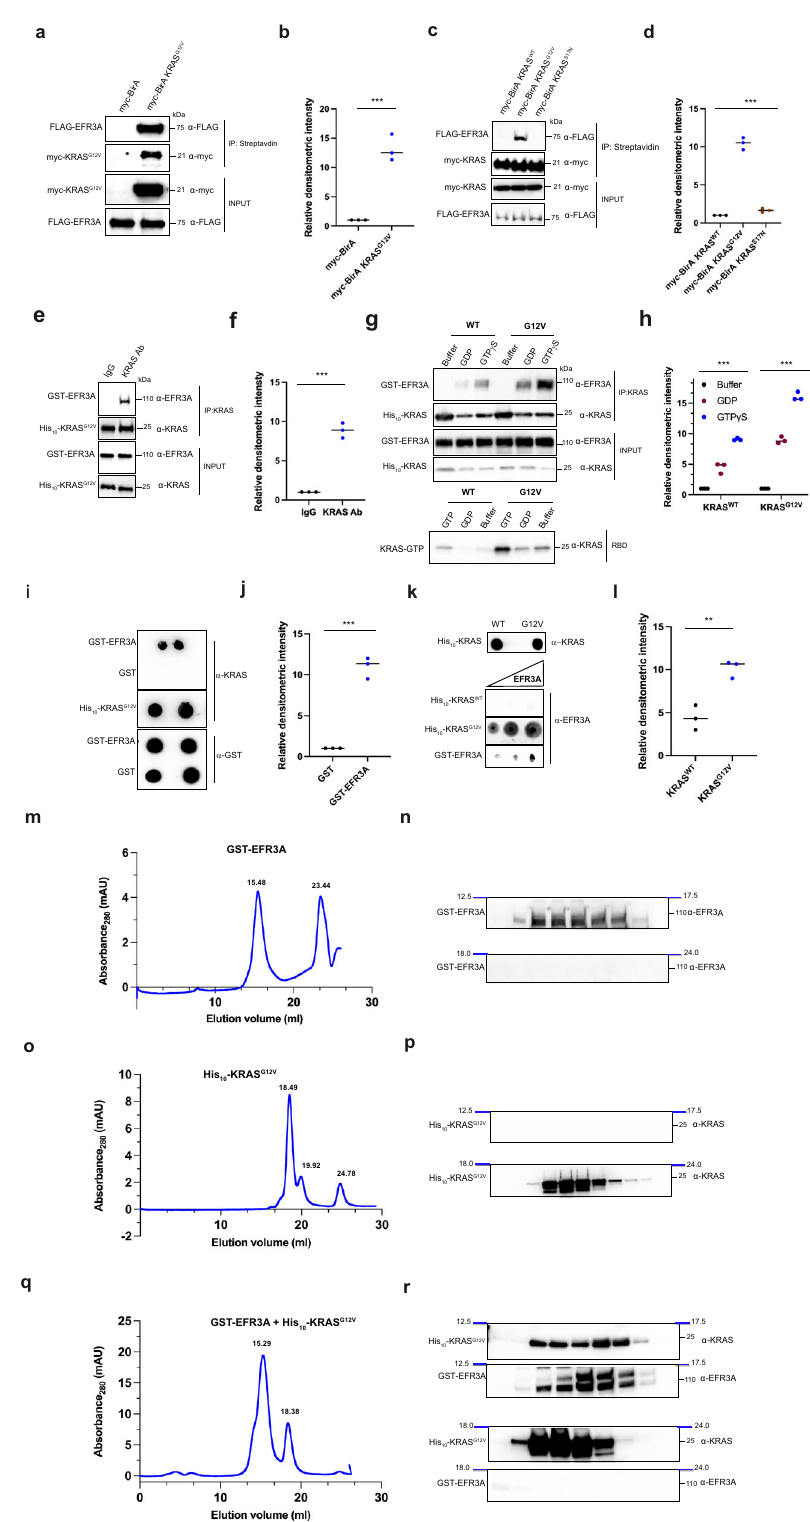
KRAS, we used the aforementioned RBD polypeptide to af fi nity was validated by demonstrating a temporal enrichment of capture endogenous GTP-bound RAS from lysates isolated EFR3A in the af fi nity-captured RAS-GTP pool after EGF sti- from the KRAS mutation-positive human pancreatic adeno- mulation of the KRAS mutation-negative BxPC3 cell line carcinoma cell line AsPC-1. Immunoblot with an EFR3A- (Supplementary Fig. 5f). Collectively, these results support the speci fi c antibody detected endogenous EFR3A (Fig. 5h). Thus, contention that EFR3A directly binds KRAS in the active GTP- endogenous EFR3A co-immunoprecipitates with endogenous bound state in a fashion resembling how activated RAS engages GTP-bound KRAS in cells. The speci fi city of this interaction with its effectors. NATURE COMMUNICATIONS| (2021) 12:5248